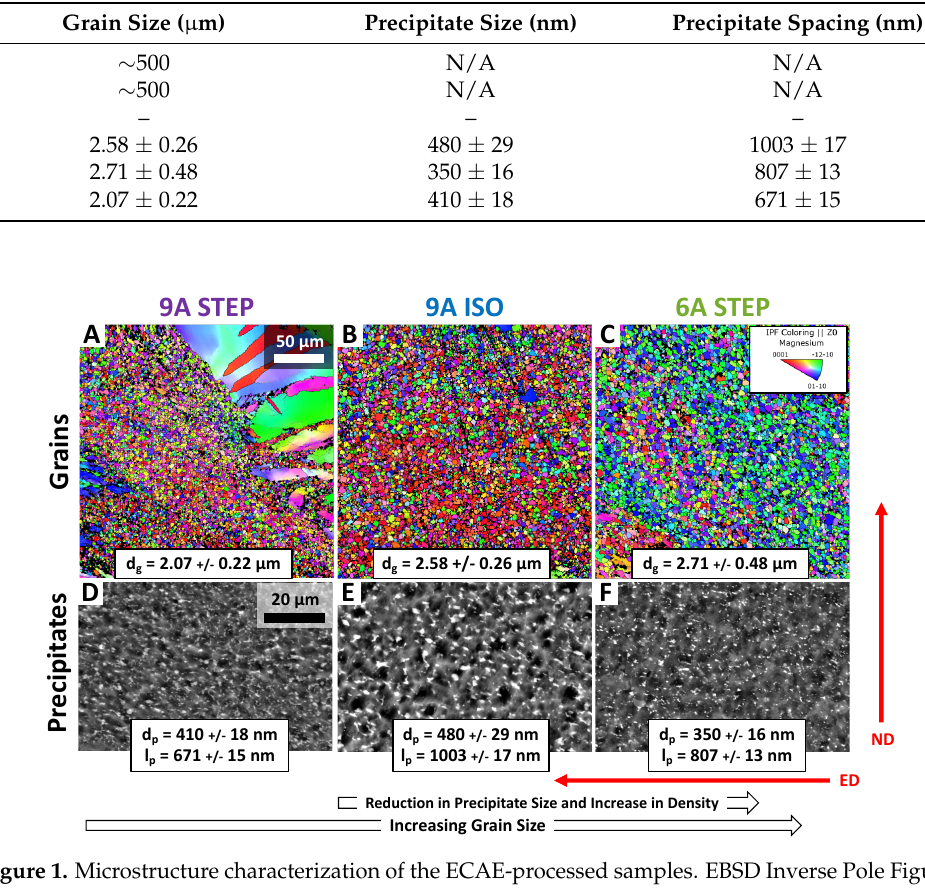
Table 1. Average values for key microstructure length scales for all sample sets. There is no data to show for 6A ISO, but the length scales are expected to resemble 9A ISO.